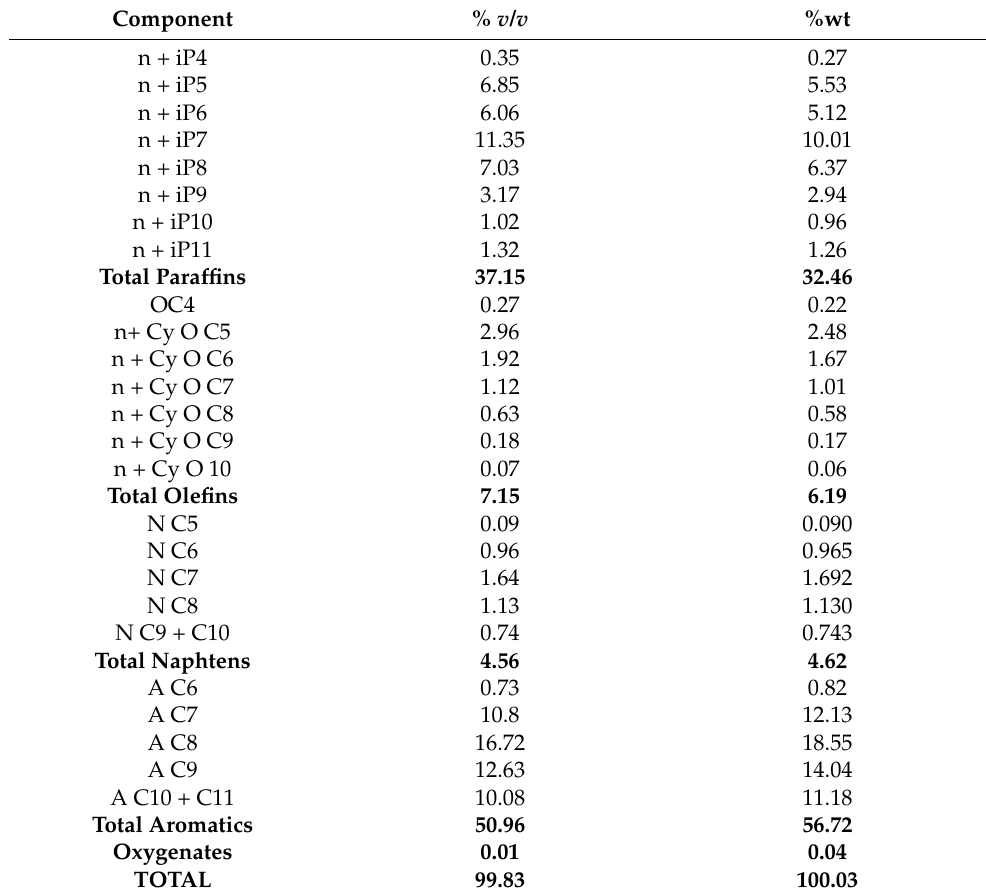
Table 1. The composition ofgasoline, expressed in % v / v and %wt.